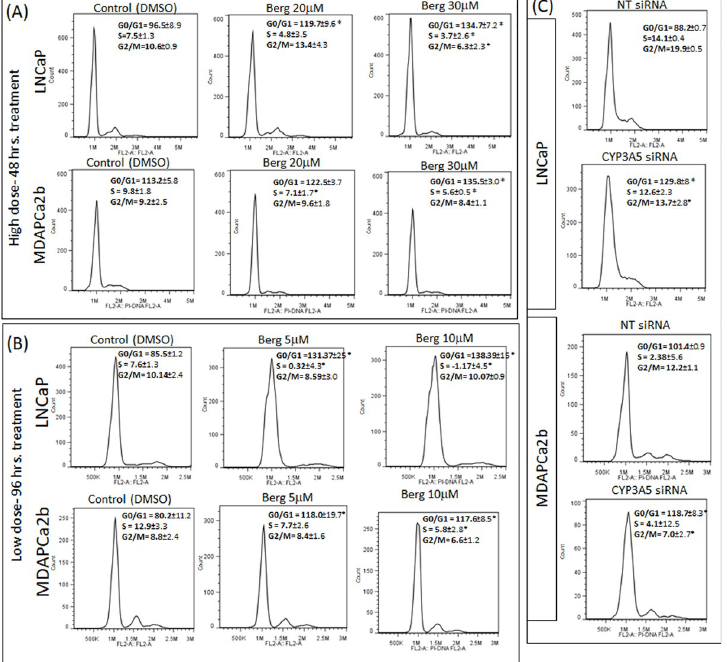
Fig 3. Bergamottin treatment causes accumulation of G0/G1 cells similar to CYP3A5 siRNA treated cells. Watson Pragmatic cell cycle analysis showing frequency of G0/G1, S, and G2/M population in the vehicle control (DMSO), bergamottin and siRNA treated cells. (A and B) Cells were treated with indicated concentration of bergamottin for indicated time points. The cell cycle analysis was performed as described in methods and the analysis was done using FlowJo software, a representative experiment is shown with Watson pragmatic analysis. The average frequency of each population and SD values ( ± ) were calculated after analysing the replicates (minimum of three) and is indicated next to each treatment conditions. ( � )- indicates that the P values was less than 0.05 when compare with the respective controls. (C)- Cells were treated with either non target (NT) pool siRNA or CYP3A5 siRNA pool. The analysis method is same as in A and